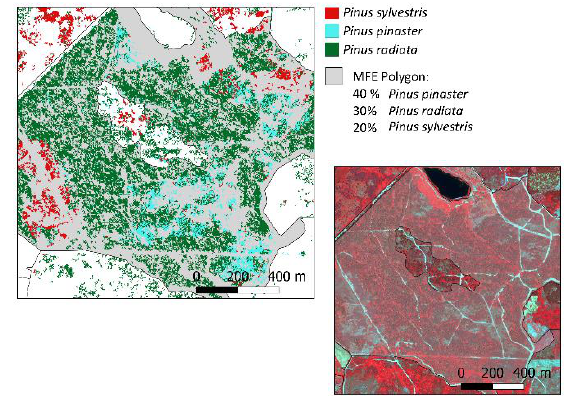
Figure 9. Comparison of the information given in a polygon from the Spanish Forest Map, MFE, (MAPA, 2011) and the information given for the same area by the classification performed in this study. Reference image Worldview-2 image in False color